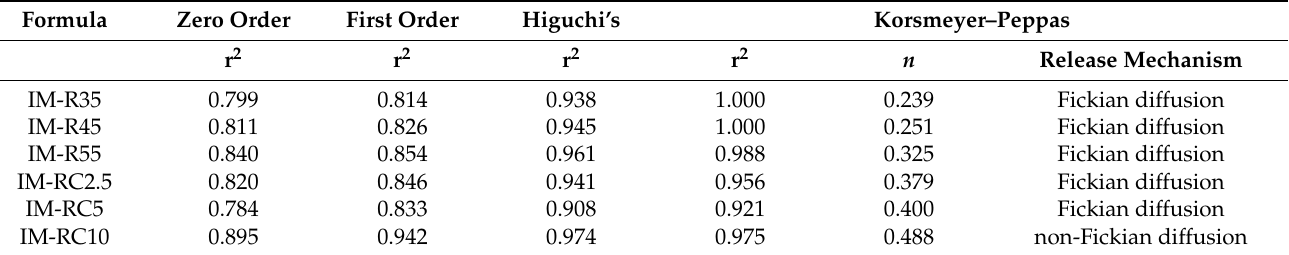
Table 2. The regression coefficient (r 2 ) value and diffusion exponent value ( n ) obtained from the IM-loaded rosin/CO-based ISG formulations.